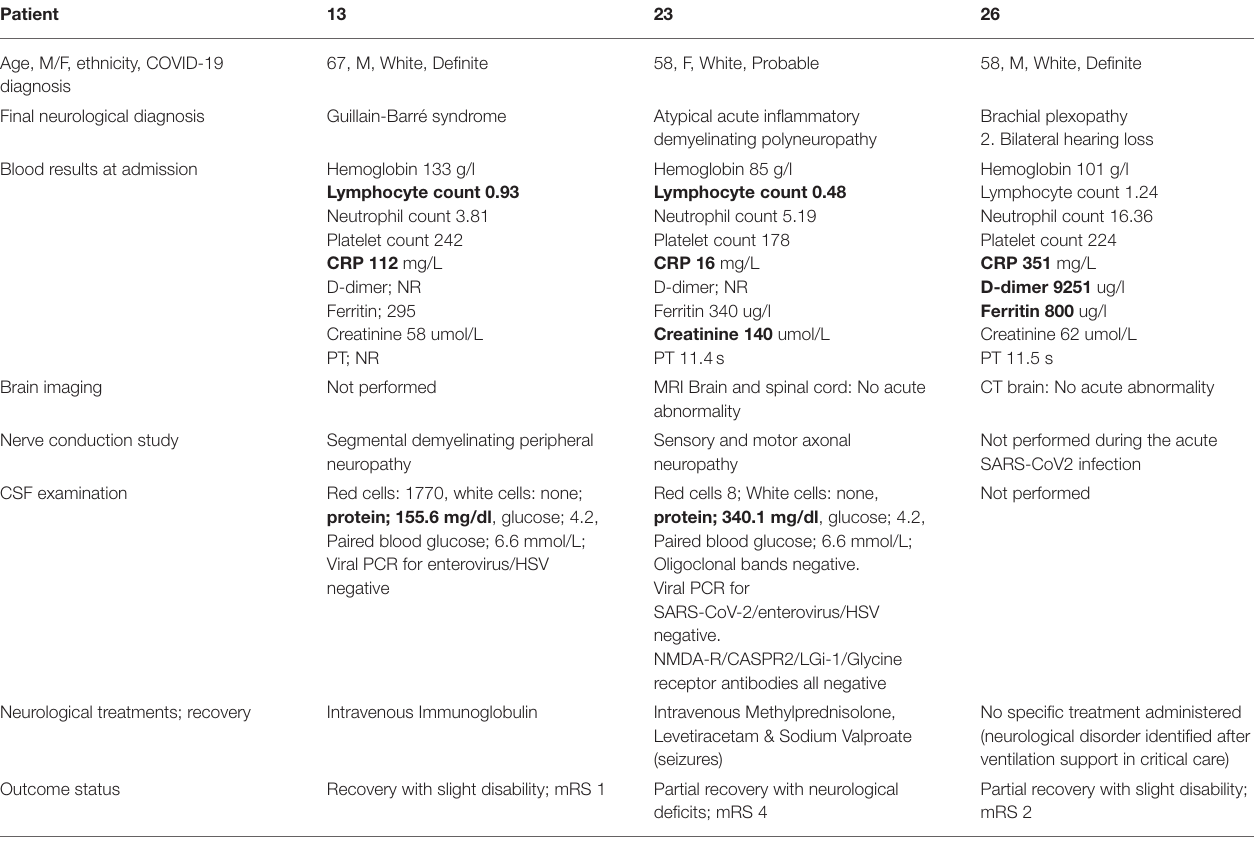
TABLE 4 | Three patients with disorders of the peripheral nervous system.